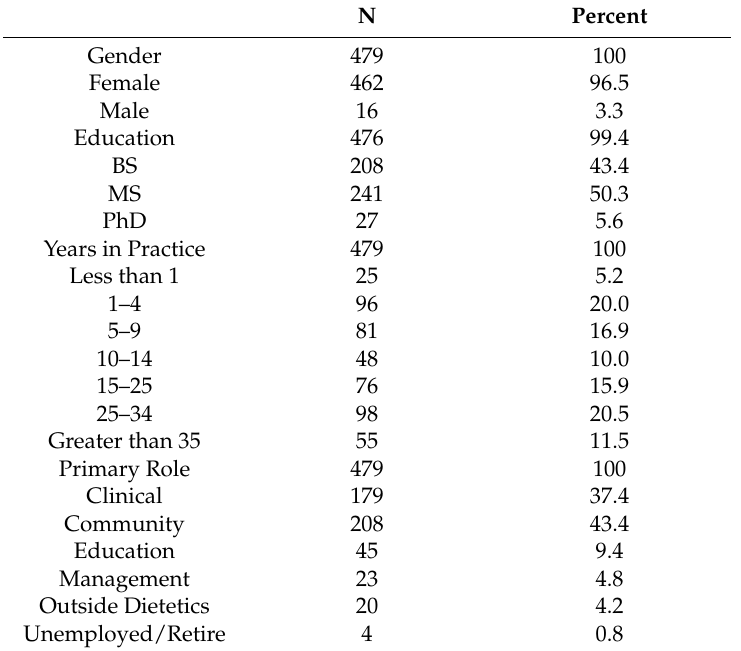
Table 1. Demographic characteristics of Registered Dietitian